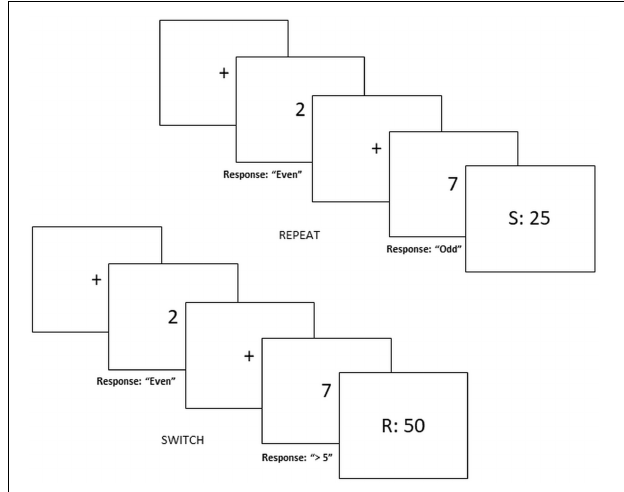
FIGURE 1 | Switch-risk task. Risky decision making depends on voluntary switching and repeating task-sets. Safe decisions yield 25 MU with a probability of 100% whereas risky decisions yield 50 MU or 0 MU with a probability of 50%. Figure represents trial in the “Switch = Risk” reward